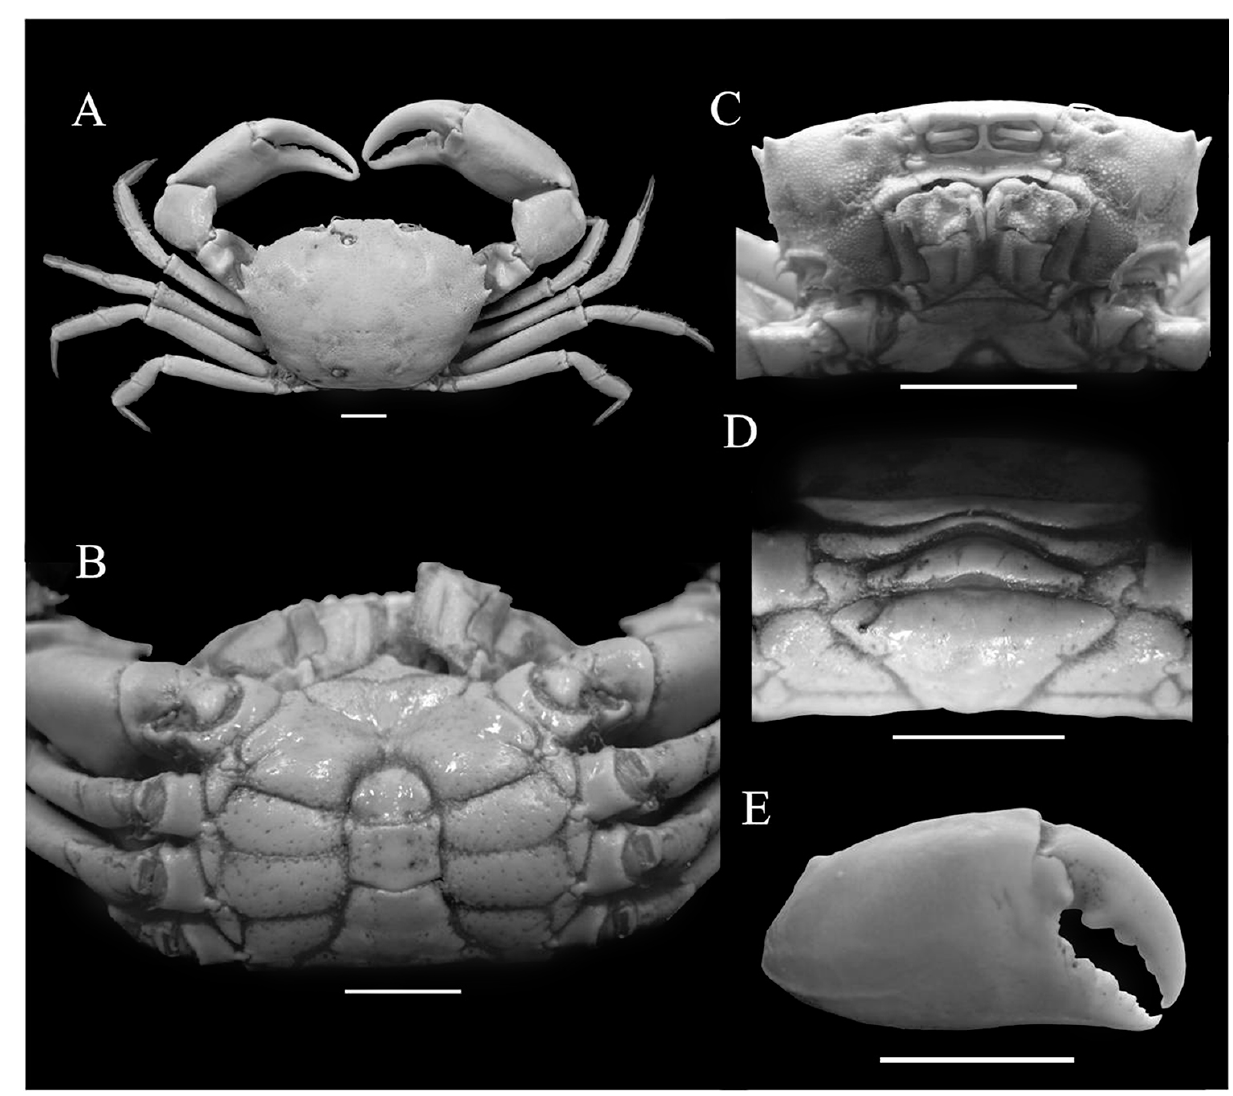
Figure 1. Pseudorhombila octodentata Rathbun, 1906, male; dorsal habitus ( A ), thoracic sternum, abdominal somites and telson ( B ), frontal view ( C ), pleonal somites 1–3, right cheliped (P1) ( D ), 130 m, MOUFPE: 19993. Scale bar: 1